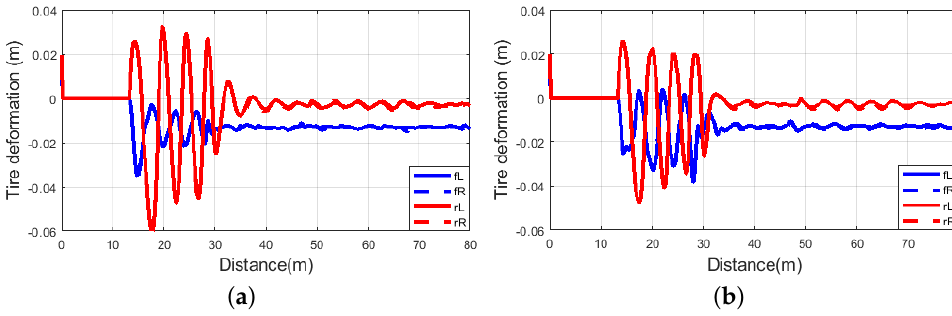
Figure 17. ( a ) Tire deformation of road roughness, ρ = 1. ( b ) Tire deformation of road roughness, ρ = 0.